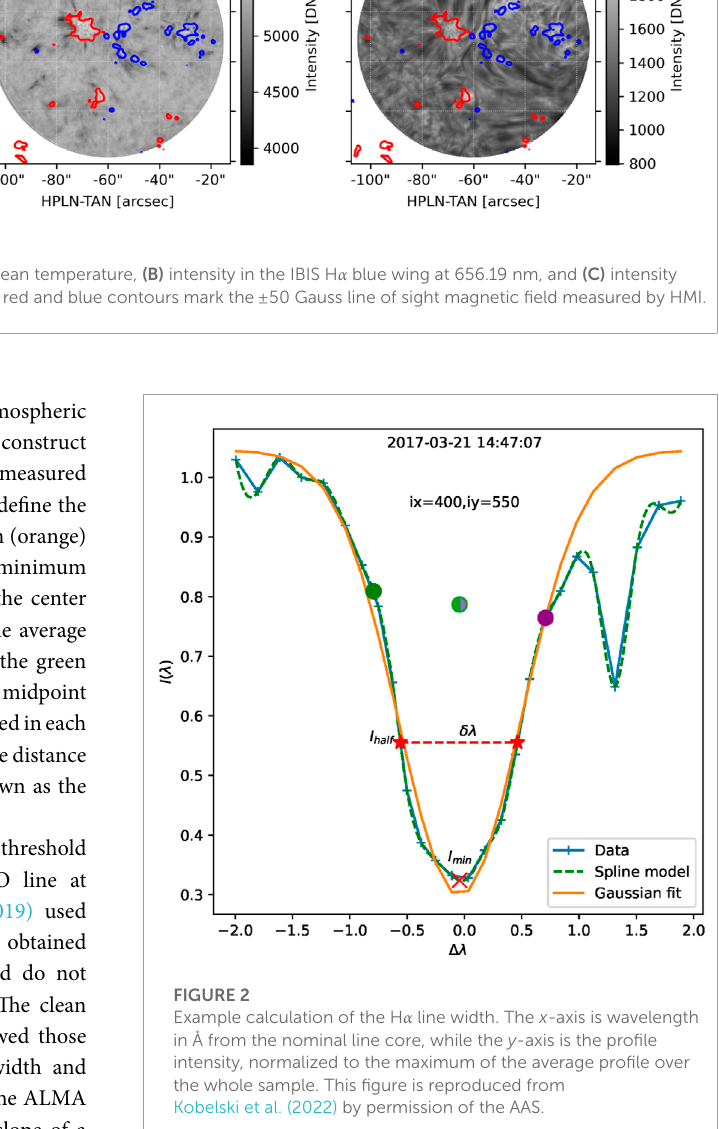
Contours of both data sets are shown in Panel (c) [see labels in Panel (a)] and provide a by-eye demonstration of the good correlation between Δ T and δλ . An animation of these four B panels for the 685 time steps in t is available in the online O material. Panel (e) shows the joint distribution of T and δλ B calculated using only pixels within the red circle from panels (a) and (c), or 2,813 pixels for this single time. This 45 ′′ diameter circle marks the conservatively-defined overlapping FOV for the two instruments, as described